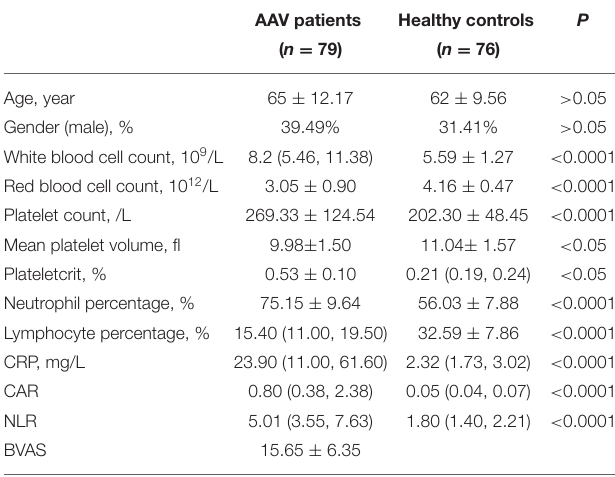
TABLE 1 | General characteristics of AAV patients and healthy controls.